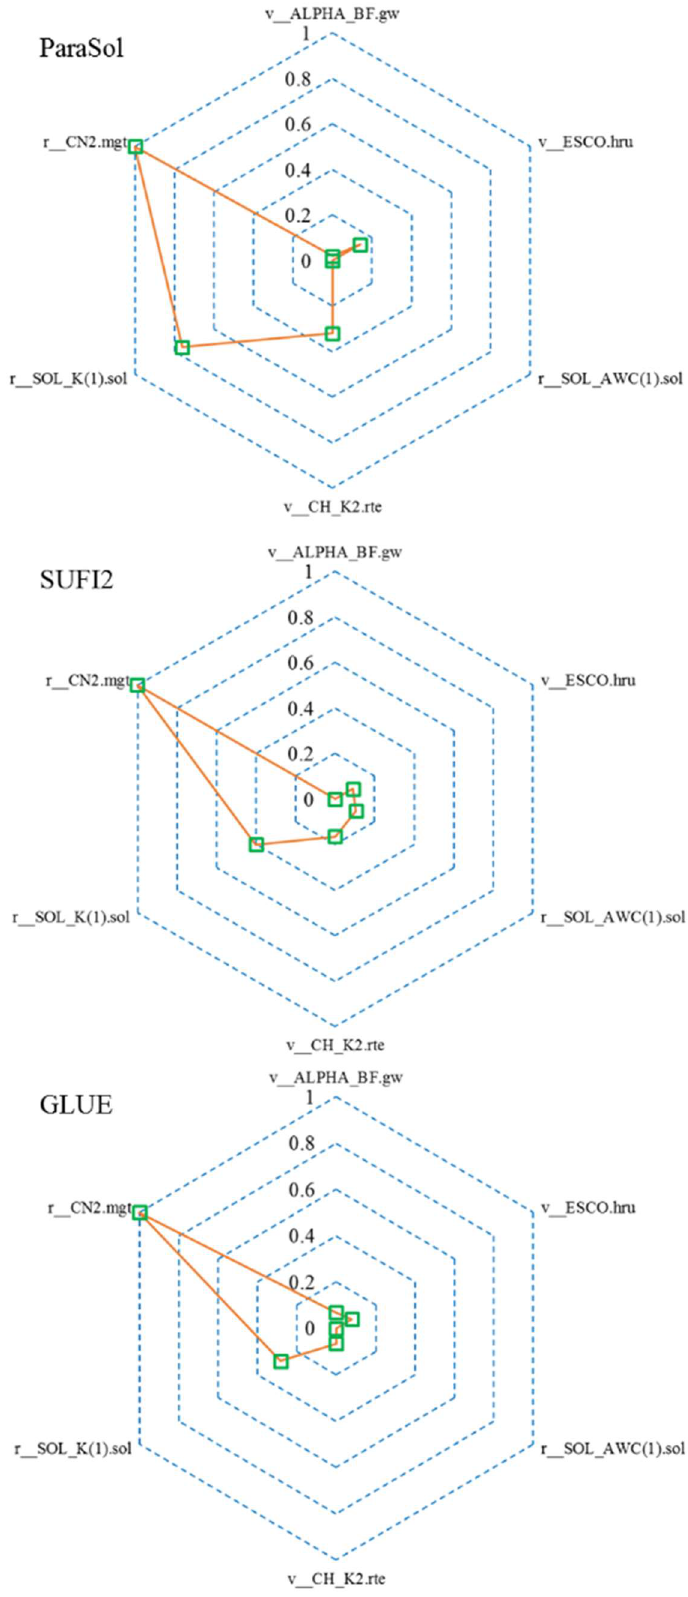
Figure 2. Graphical representation of the parameter sensitivity rank for streamflow yielded by ParaSol, SUFI2, and GLUE. The sensitivity result has been normalized, and a value close to one indicates the parameter is more sensitive to streamflow. The green box means the sensitivity magnitude of a parameter.